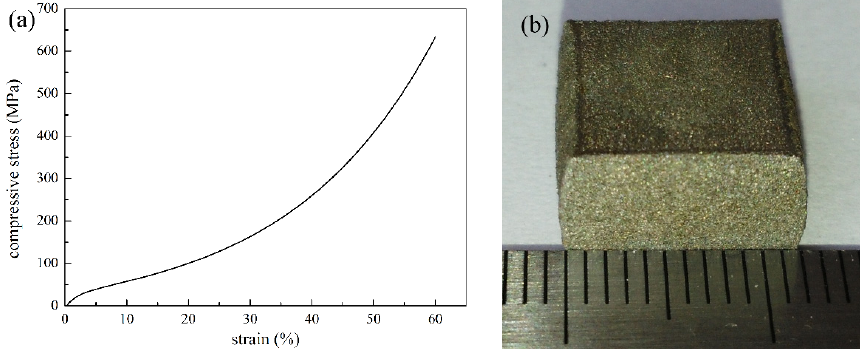
Figure 2. ( a ) Compressive curve; and ( b ) the picture after compression test of sample